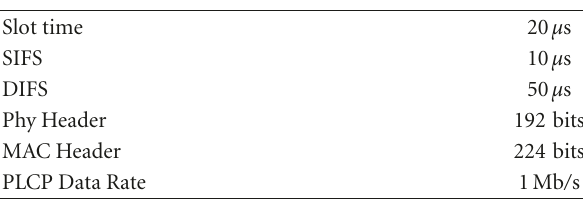
Table 1: IEEE 802.11 System Parameters.